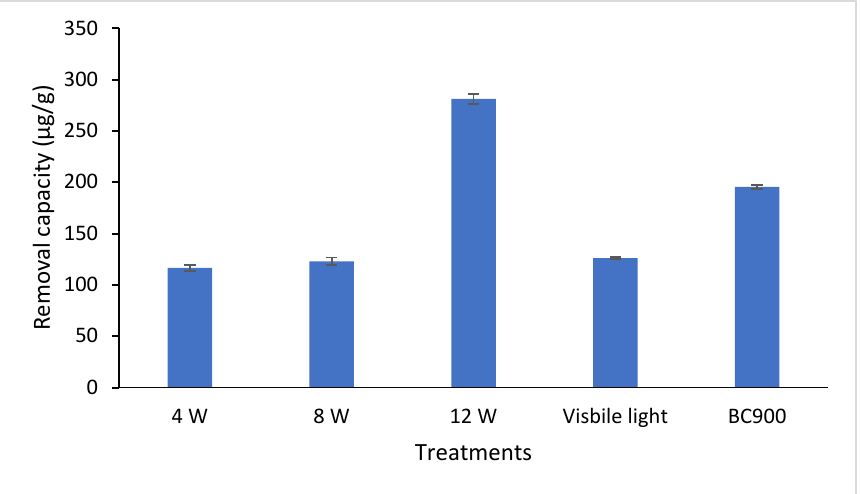
Figure 8. As removal capacity with different treatment scenarios. Experimental conditions: pH = 8, As(III) initial concentration = 2.5 mg/L, adsorbent dose = 5 g/L.